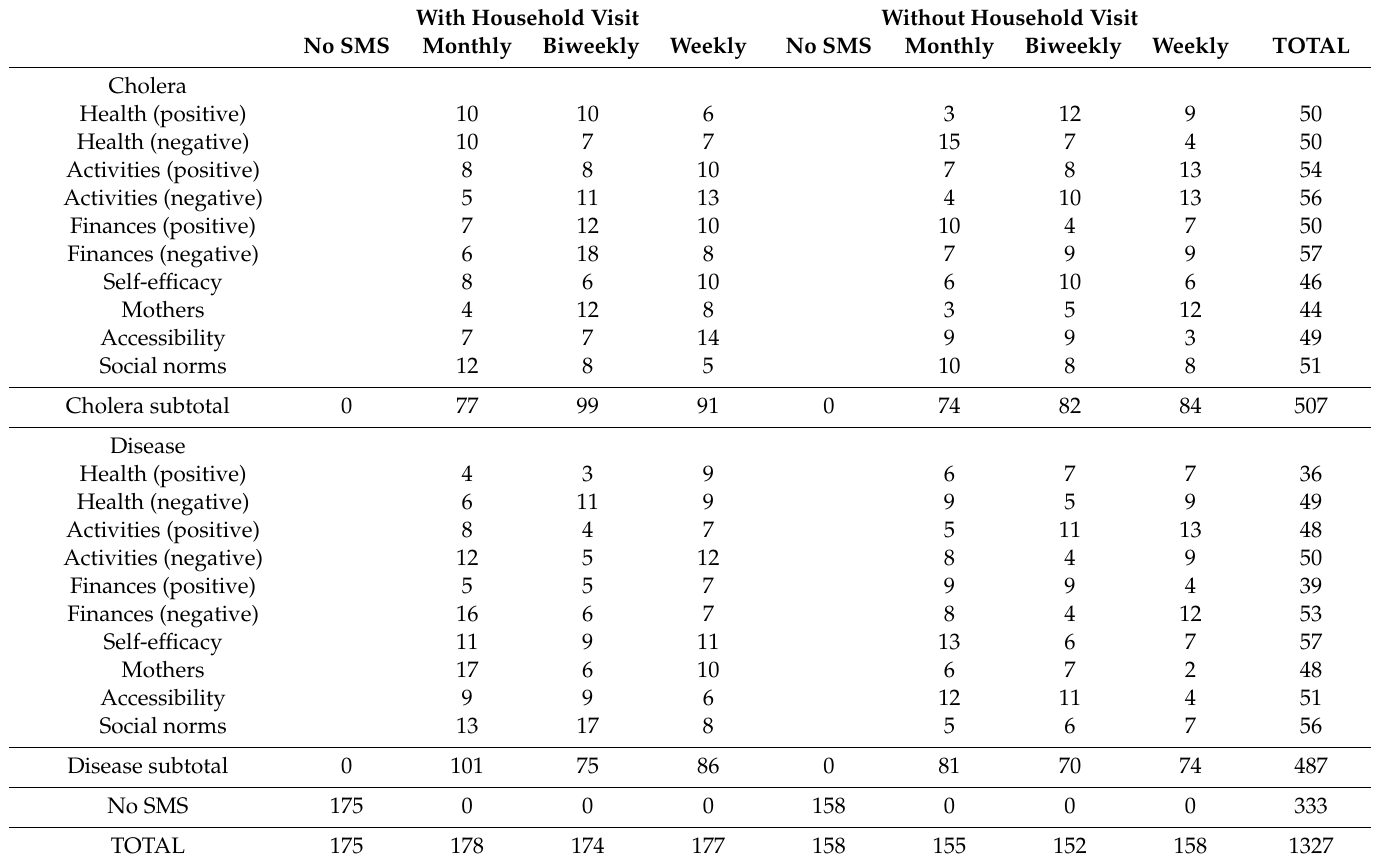
Table 1. Number of households assigned to each treatment